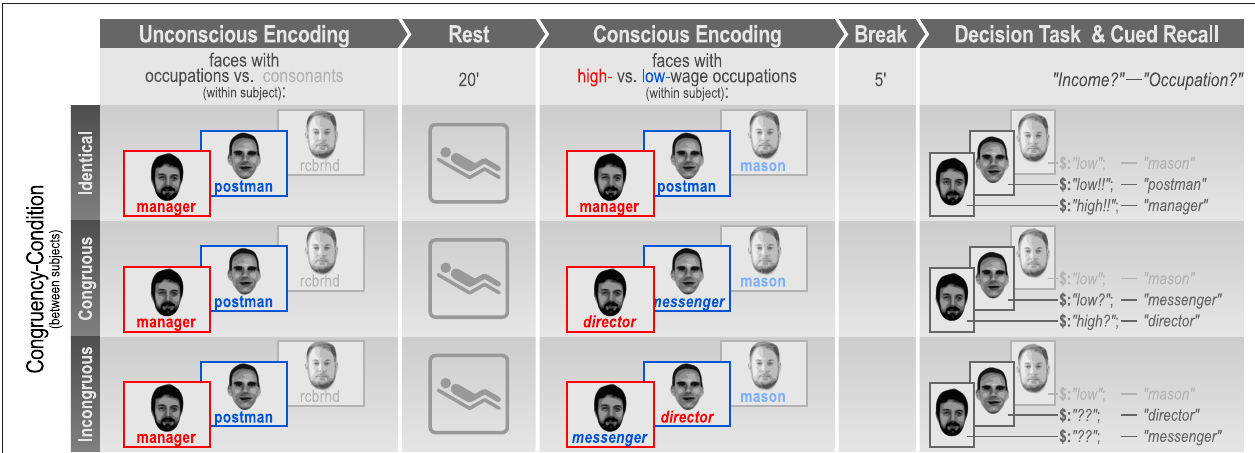
FIGURE 1 | Experimental Design. Participants were presented with subliminal combinations of faces and written high- (blue) or low-wage (red) occupations or consonant strings (light gray: control condition). Subliminal encoding was followed by a rest period of 20min. Next, participants consciously encoded the same faces presented supraliminally now combined with either the same occupations, congruous or incongruous occupations. The decision task followed after another break. All faces were shown again, without any occupations, for participants to rate each person’s putative income and then to try to recall the person’s occupation as learned before. The individuals depicted in this figure gave written informed consent to publication of their image.